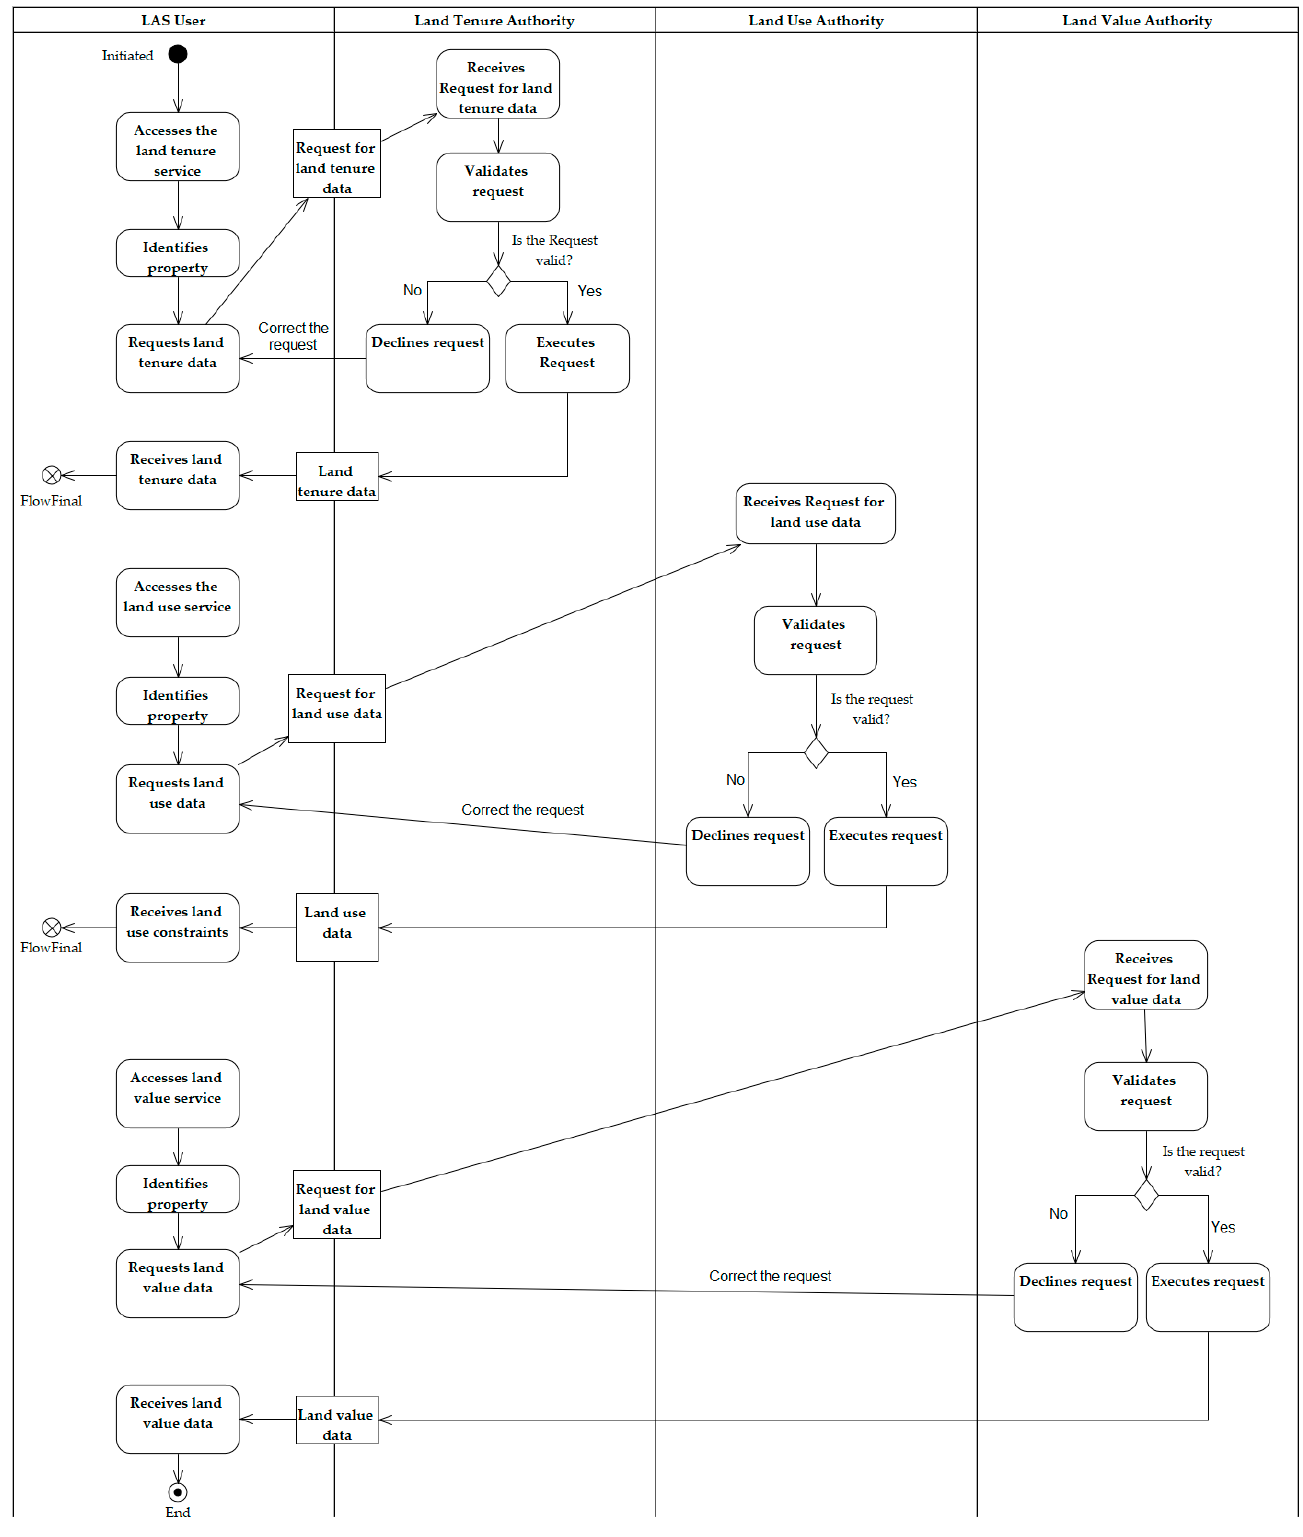
Figure 3. Current state of the examined use case. Source: Own compilation.